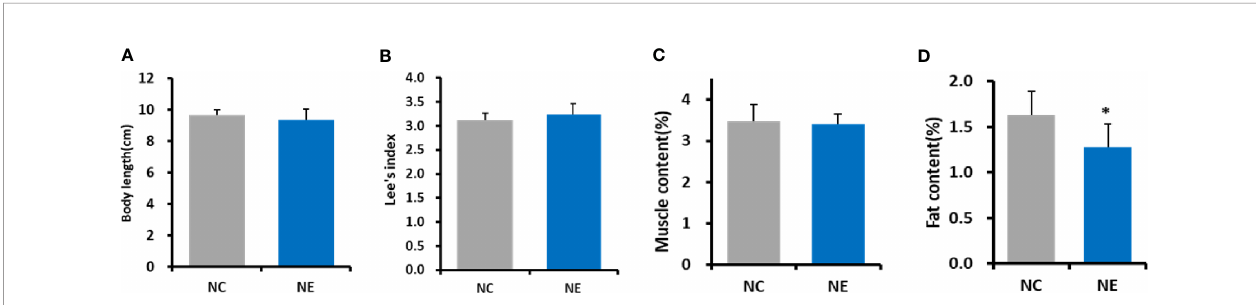
FIGURE 2 | Body length, Lee ’ s index, muscle content (%), and fat content (%). Independent-samples t test were used to compare the groups. (A) body length. ffiffiffiffiffiffiffiffiffiffiffiffiffiffiffiffiffiffiffiffiffiffiffiffiffiffiffiffiffiffiffiffi p (cid:3) body weight (g) (cid:1) 1000 3 (B) Lee ’ s index = ; (C) Muscle content (%) = [tibialis anterior muscle (g) + gastrocnemius (g) + quadriceps femoris (g)]/body weight (g) body length (cm) * 100; (D) , Fat content (%) = [perirenal fat (g) + inguinal fat (g) + epididymal fat (g)]/body weight (g) * 100. NC = control group; NE = exercise group. Compared with the NC group, *p < 0.01.